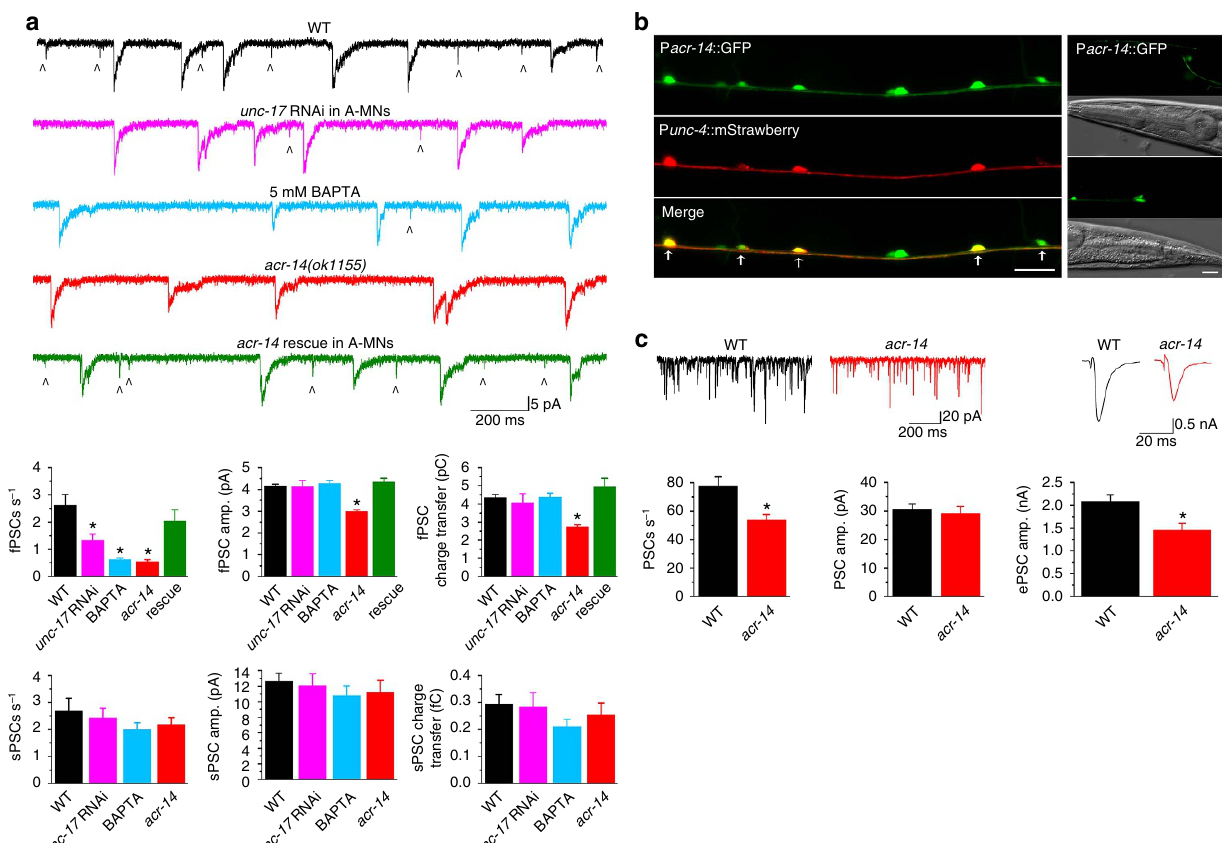
Figure 5 | ACR-14 acts as an autoreceptor to mediate fast PSCs (fPSCs) in VA5 and enhances spontaneous and evoked neurotransmitter release. ( a ) Sample traces of spontaneous PSCs and statistical comparisons among wild type (WT), unc-17 knockdown (RNAi) specifically in A-type cholinergic motor neurons (A-MNs), WTrecorded with BAPTA in the pipette solution, acr-14(ok1155) , and acr-14(ok1155) rescued specifically in A-MNs by expressing wild-type ACR-14 under the control of P unc-4 . fPSCs are marked by the caret sign (^). The sample size ( n ) was 11 WT, 7 unc-17 RNAi, 5 BAPTA, 9 acr- 14(ok1155) , and 7 acr-14(ok1155) rescue. ( b ) In a strain coexpressing GFP under the control of P acr-14 and mStrawberry under the control of P unc-4 , all A-MNs are colabelled by the two fluorescent proteins (left). GFP expression was also observed in a few head (right top) and tail (right bottom) neurons in this strain. Corresponding differential interference contrast images are shown below. Scale bar, 20 m m. ( c ) The frequency of spontaneous PSCs and the amplitude of evoked PSCs recorded from body-wall muscle cells are decreased while the mean amplitude of spontaneous PSCs has no change in acr- 14(ok1155) ( n ¼ 15) compared with WT ( n ¼ 14). The asterisk (*) indicates a statistically significant difference compared with WT based on either one-way ANOVA with Tukey’s post hoc test ( a ) or unpaired t -test ( c